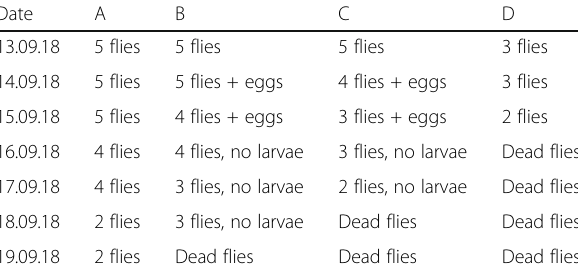
Table 5 Olfactory Response Index (ORI) for normal Z. indianus